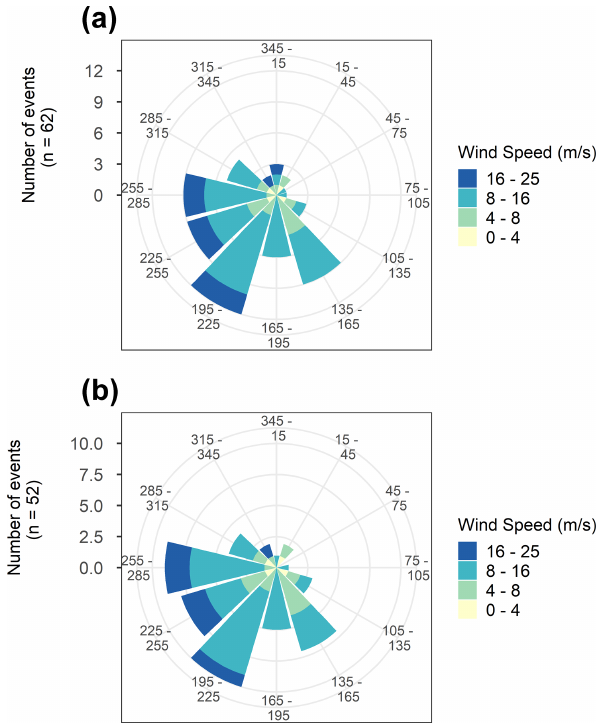
Figure A4. Wind direction measured by the radiosondes at 2.7km of (a) the 62 snowfall events and (b) the 52 snowfall events coincid- ing with running mean RH ice ≥ 97% throughout the lower 2.7km (see Sect. 3.2 for criterion).